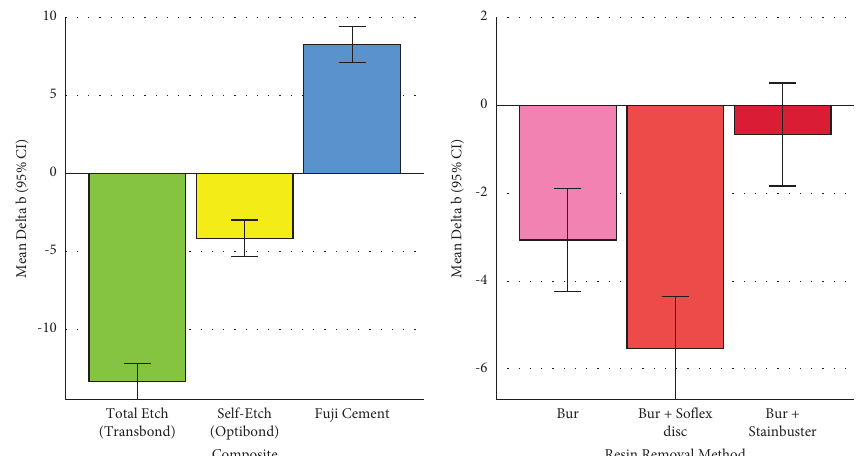
Figure 3: Means (and 95% CIs) for the Δ b parameter in 3 composites ( n � 3 × 30) and 3 adhesive removal methods ( n � 3 × 30). Negative values indicate shades of blue, while positive values indicate shades of